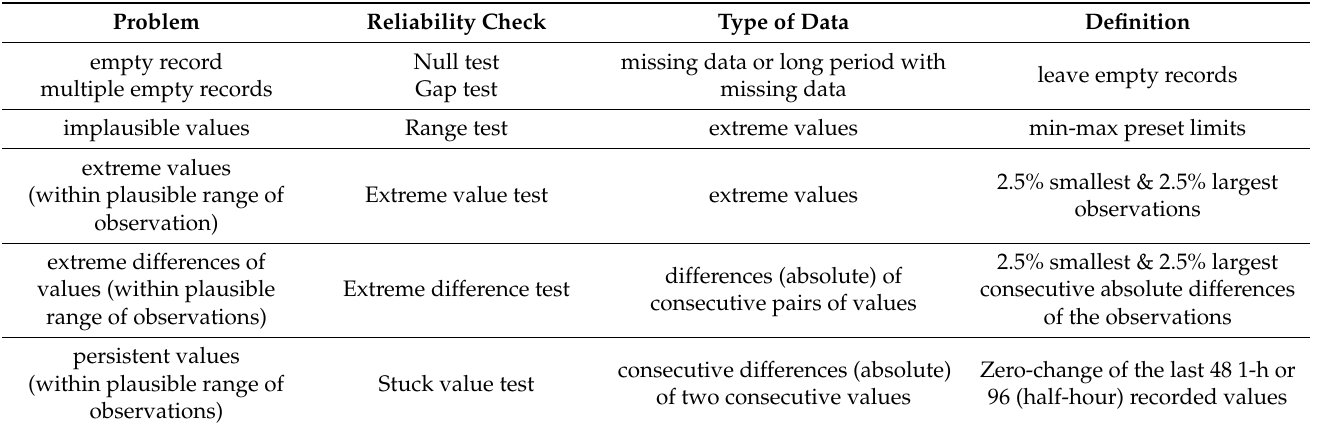
Table 2. Quality tests applied to the data recorded by the HCMR automatic